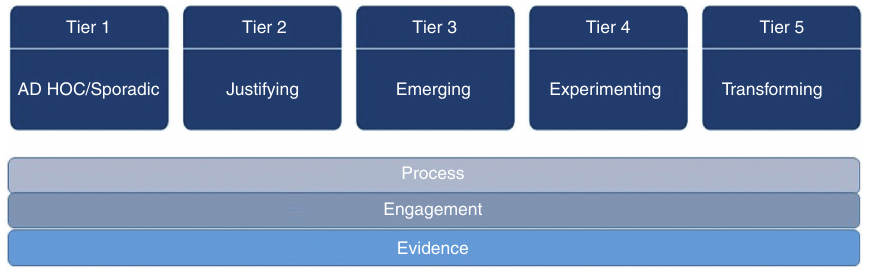
Fig. 2: The Evidence Based Library and Information Practice Capability Maturity Model (Thorpe & Howlett,